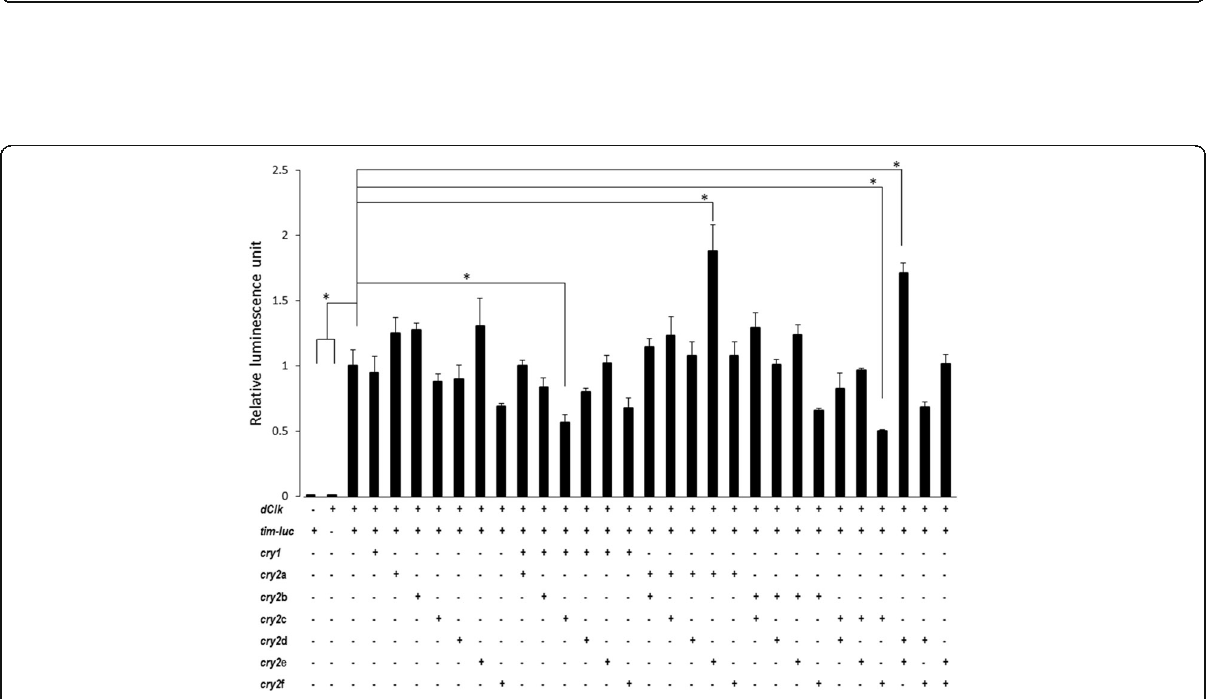
Fig. 6 Suppressive effects of Gb ’ CRY1 or Gb ’ CRY2 proteins on tim transcription. Relative luciferase activity of tim-luc was measured in the presence of 100 ng of pAc-Clk with various combinations of the indicated pAc5.1B-Gb ’ cry1, pAc5.1B-Gb ’ cry2 a, -b, -c, -d, -e, or -f expression plasmids. Signals were normalized to Rluc activity and then to the control signal of cells transfected with 100 ng of tim-luc and pAc-Clk . Error bars represent SEM ( n = 3). A combination of Gb ’ cry2 b and Gb ’ cry2 c suppressed the transcription of E-box genes. Asterisks represents P < 0.01 versus control (Dunnett ’ s multiple range